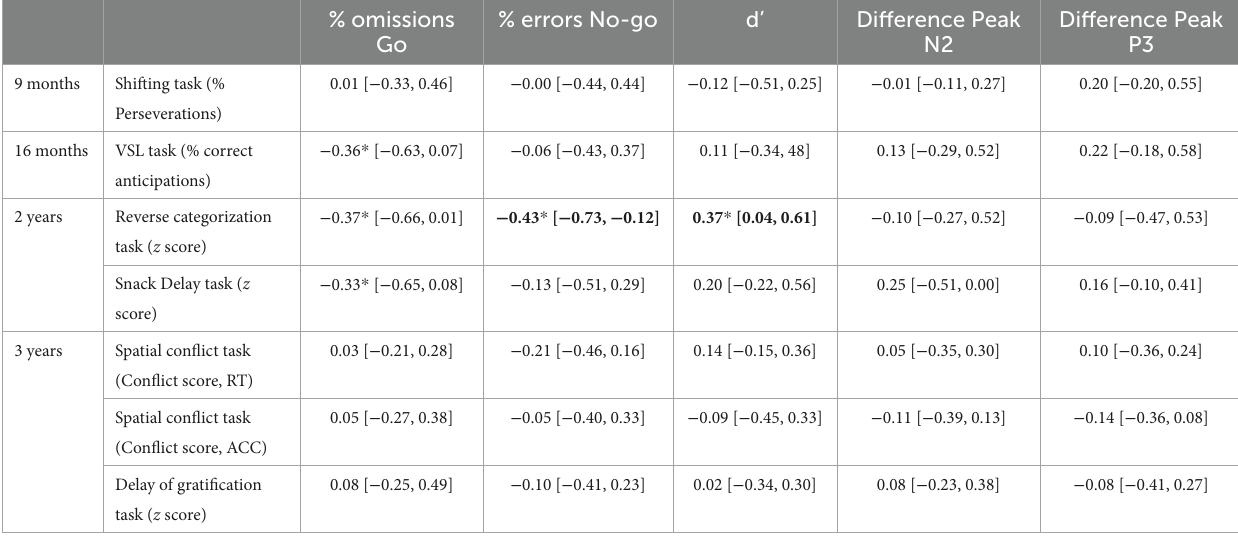
TABLE 4 Correlations between early measures of executive attention and inhibitory control indicators at 5 years of